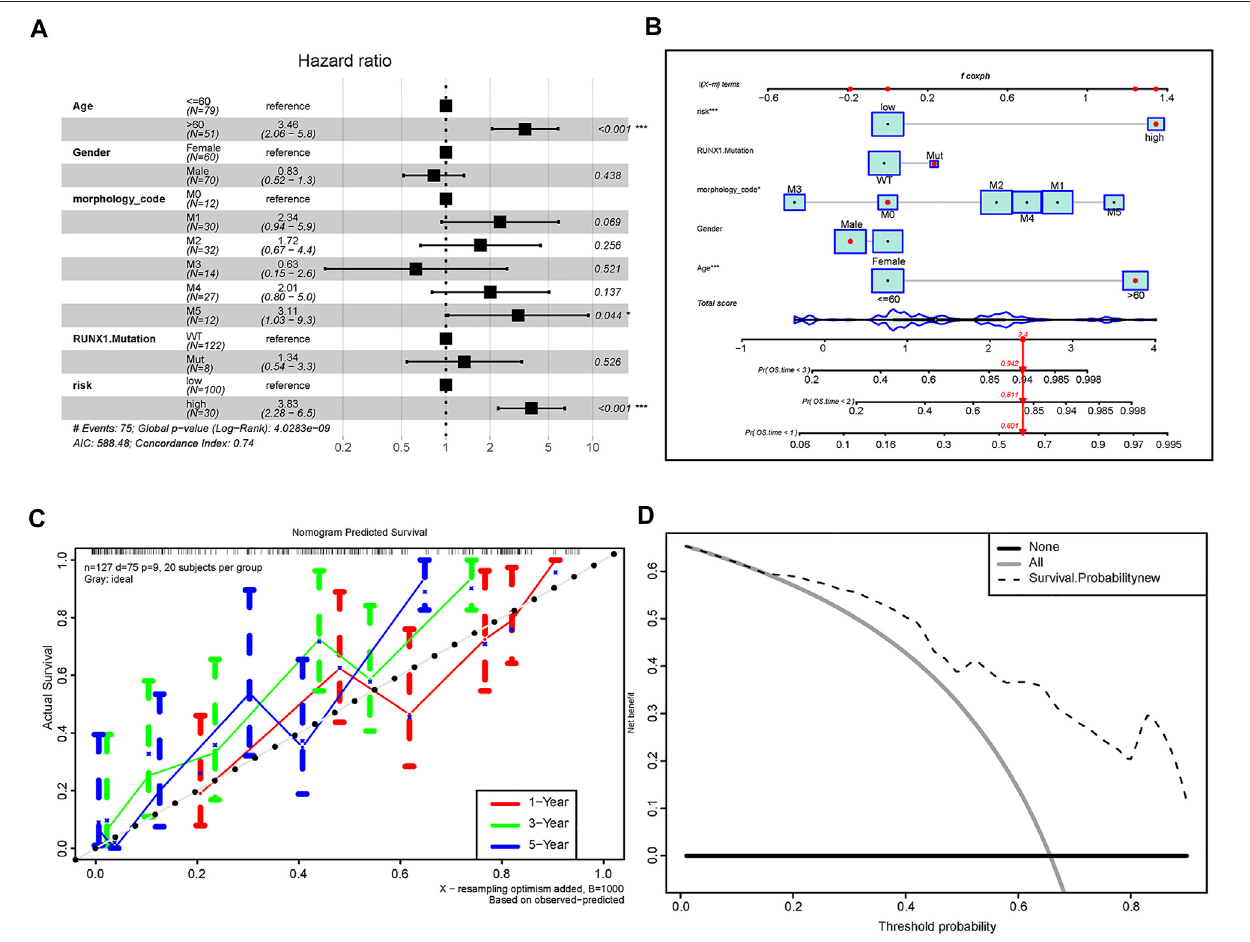
FIGURE 7 | Predictive ability of the constructed model for the OS of AML patients. (A) Multivariate Cox regression analysis of risk scores combined with clinicopathological characteristics, which indicate that risk score, age, and M5 subgroup are independent risk factors for the prognosis of AML patients. (B) Nomogram showingclinicopathologicalcharacteristicssuchasage,gender,morphologicalsubtype,RUNX1mutation,andriskscoresandmanifestinggreatpredictiveaccuracyfor 1-, 2-, and 3-year survival rates. (C) Calibration curve of nomogram. X-axis indicates the survival situation predicted by the nomogram, and Y-axis indicates actual observed survival. Repeated 1,000 times in each run, the curve demonstrate that the model had an excellent predictive value for the prognosis of patients at 1, 3, and 5 years. (D) Decision curve analysis of nomogram; Y-axis indicates the net bene fi t, the dotted line indicates the bene fi t predicted by the model, the gray curve represents the bene fi t rate of all patients receiving the intervention, and the horizontal line indicates the bene fi t rate of the whole patients not received intervention. Take the intersection of the dotted line and all as the starting point, and the intersection with none as the end. Patients within this range can bene fi t from